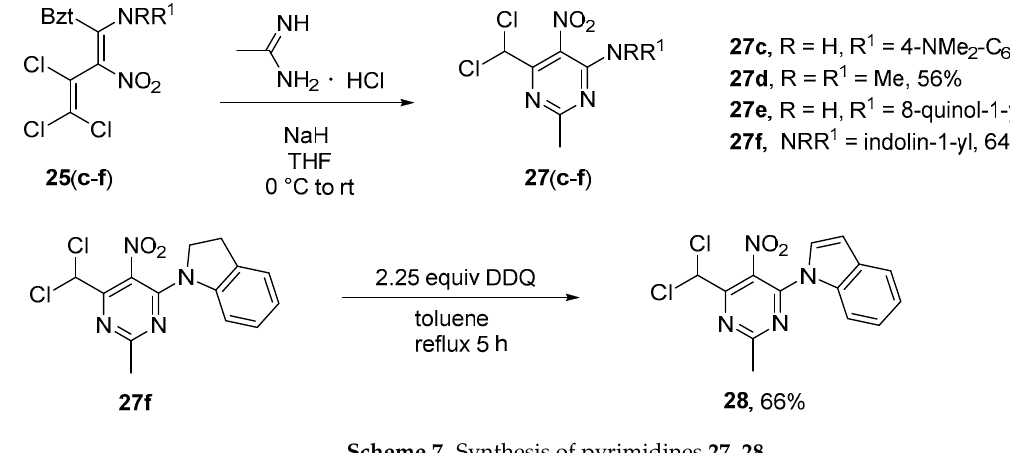
Scheme 7. Synthesis of pyrimidines 27 , 28